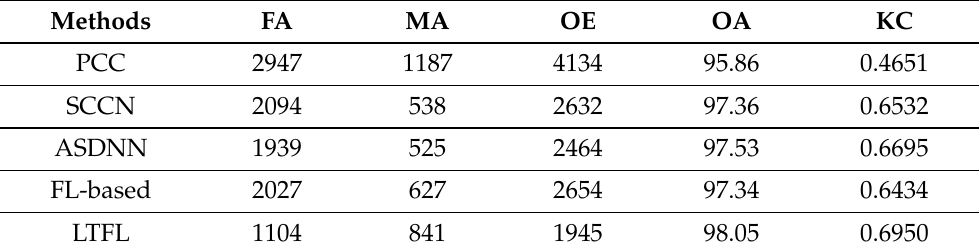
Table 18. Quantitative results for heterogeneous images